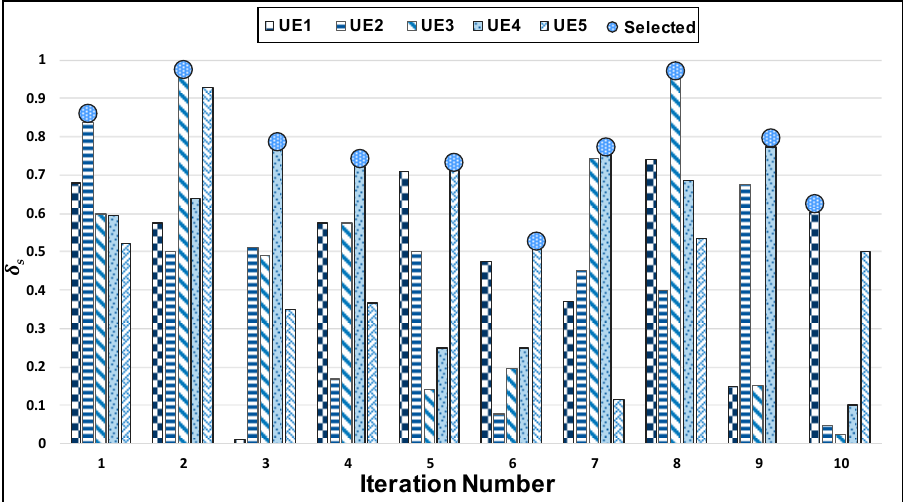
Figure 6. Selection of UE with the best ẟ s values.